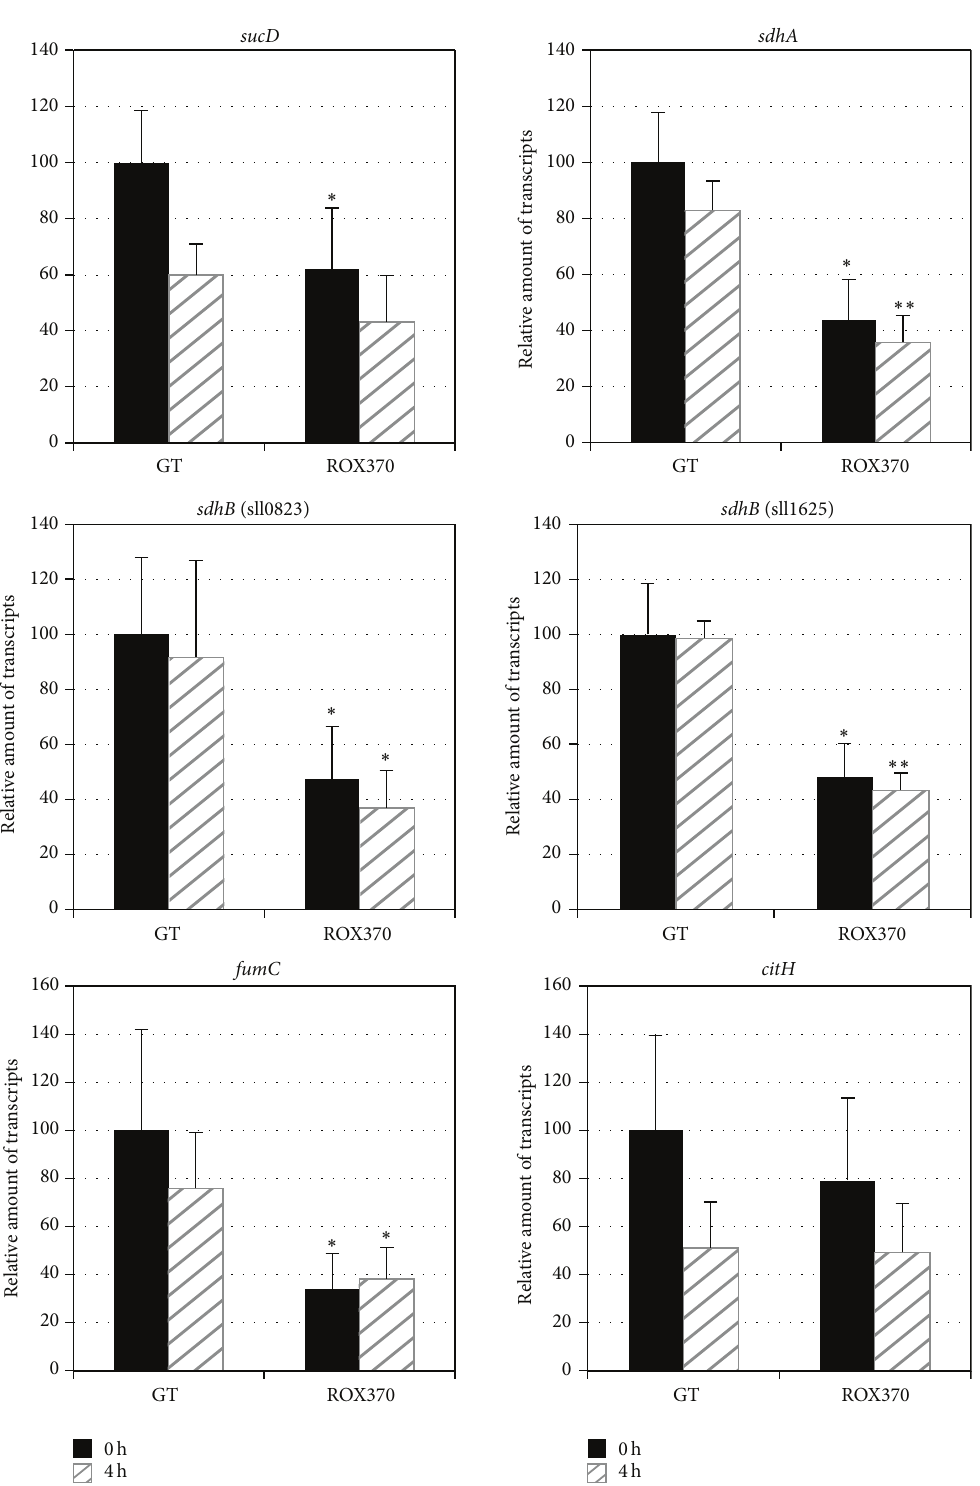
Figure 2: Quantitative real-time PCR analysis of transcription in GT and ROX370. Relative transcript levels of 6 genes involved in the TCA cyclepathway( sucD , sdhA , sdhB (sll0823), sdhB (sll1625), fumC ,and citH )aredescribed.Datarepresentthemean ± SDfromfourindependent experiments. Transcript levels were calibrated relative to that of corresponding levels in GT under nitrogen-replete conditions (set at 100%). Asterisks indicate statistically significant differences between GT and ROX370 (Student’s 𝑡 -test; ∗ 𝑃 < 0.05 , ∗∗ 𝑃 < 0.005